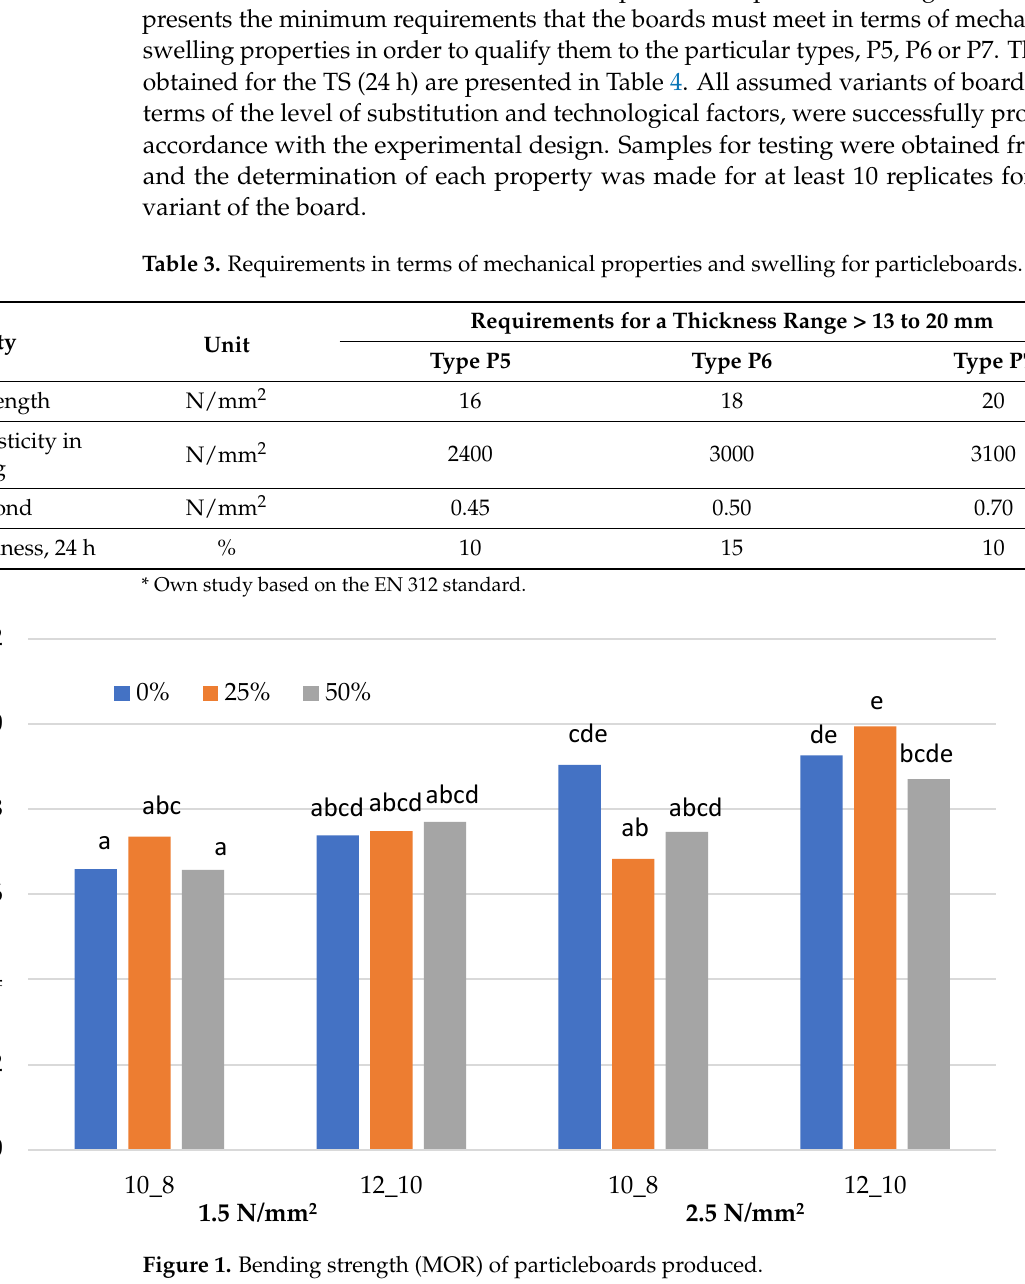
Figure 2. Modulus of elasticity (MOE) of particleboards produced.